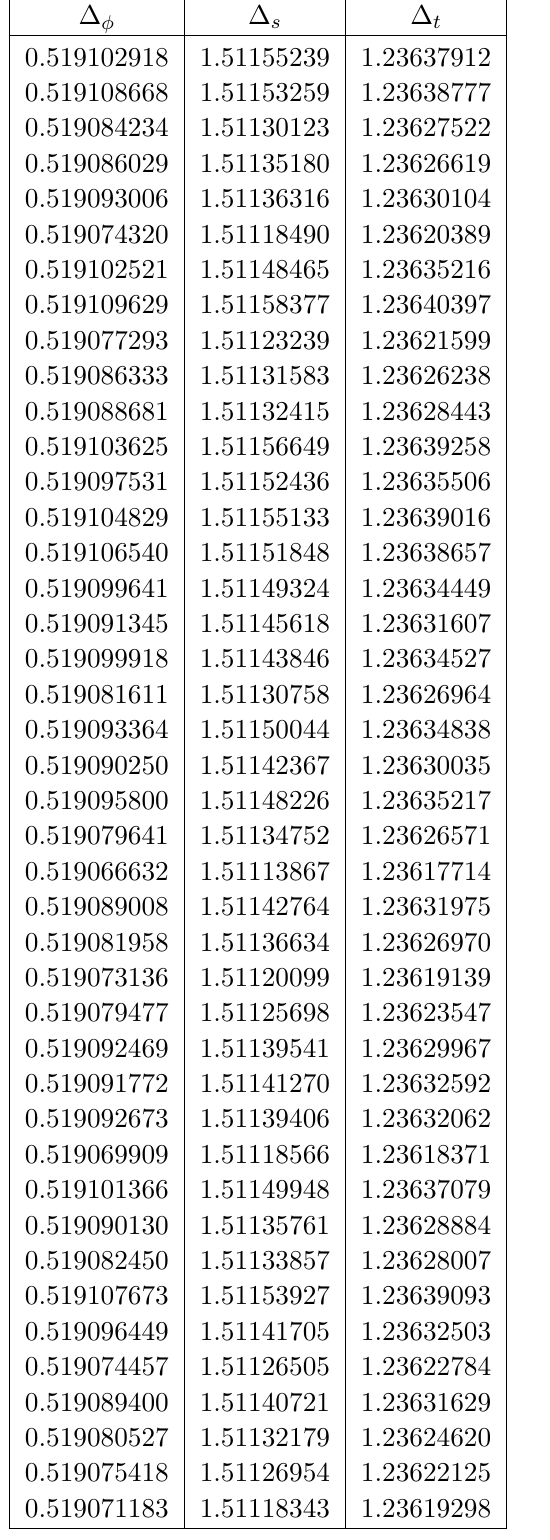
Table 8 . Disallowed points computed at (cid:3) =